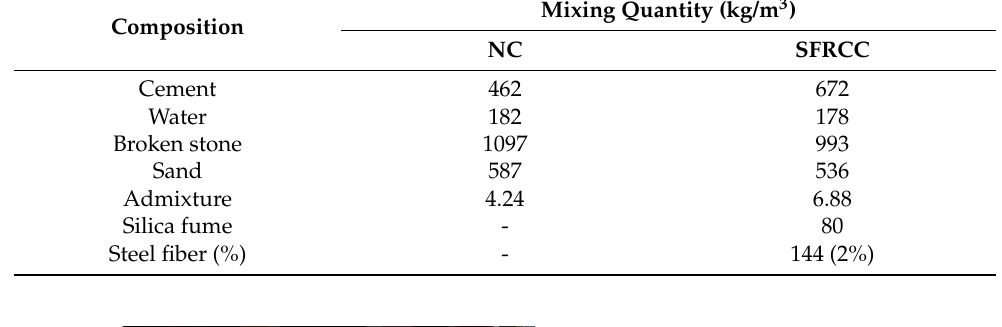
Figure 3. Measurement of mechanical properties: ( a ) concrete compression test; ( b ) concrete bending test; and ( c ) rebar tensile test. Table 2. Mechanical Properties of Materials.